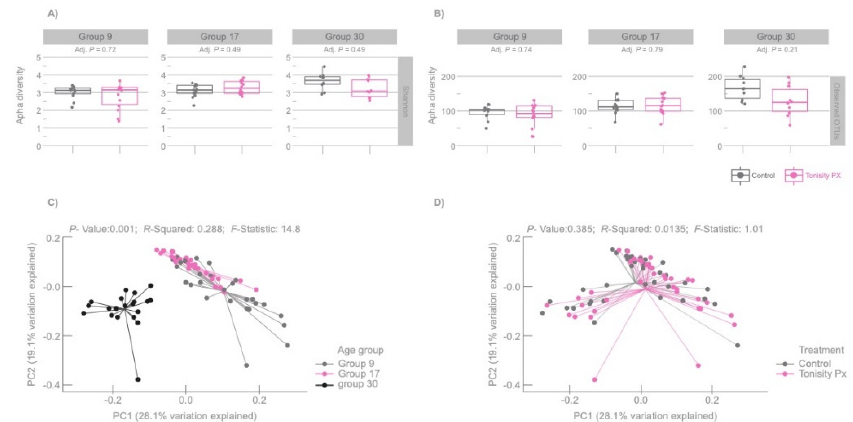
Figure 1. Shannon diversity index ( A ), alpha-diversity observed Operational Taxonomic Units OTUs ( B ), and beta-diversity (weighted UniFrac) of gut microbiota communities in piglets at 9, 17, and 30 days of age ( C ) and in Control and piglets supplemented with Tonisity Px ( D ).